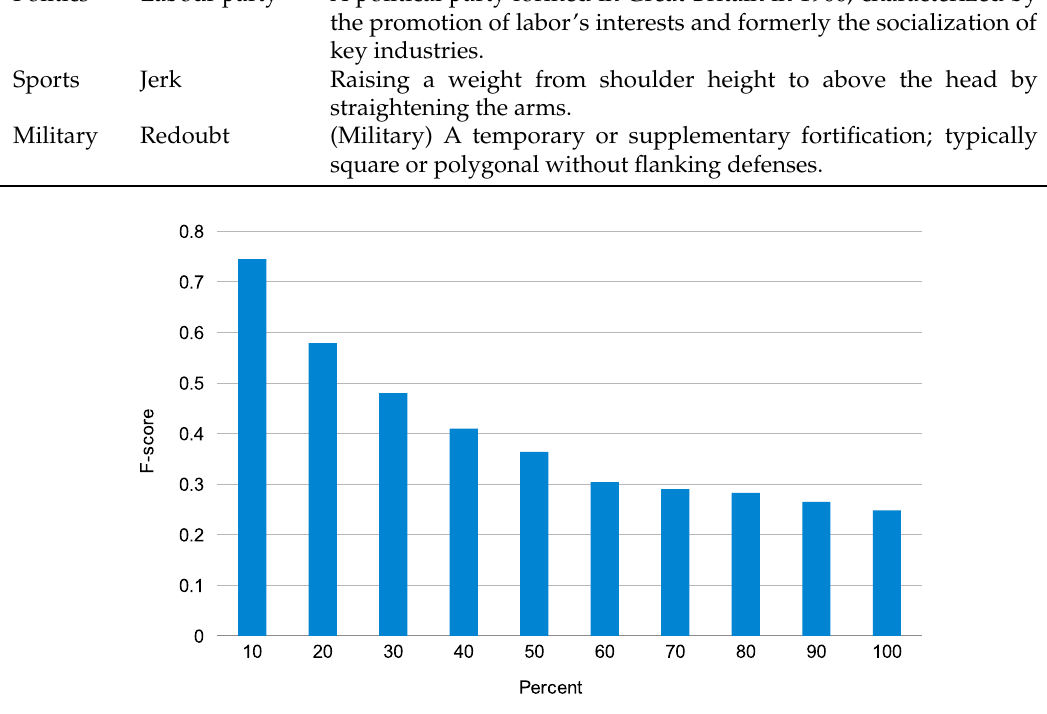
Figure 3. F-score against the percent of topmost of